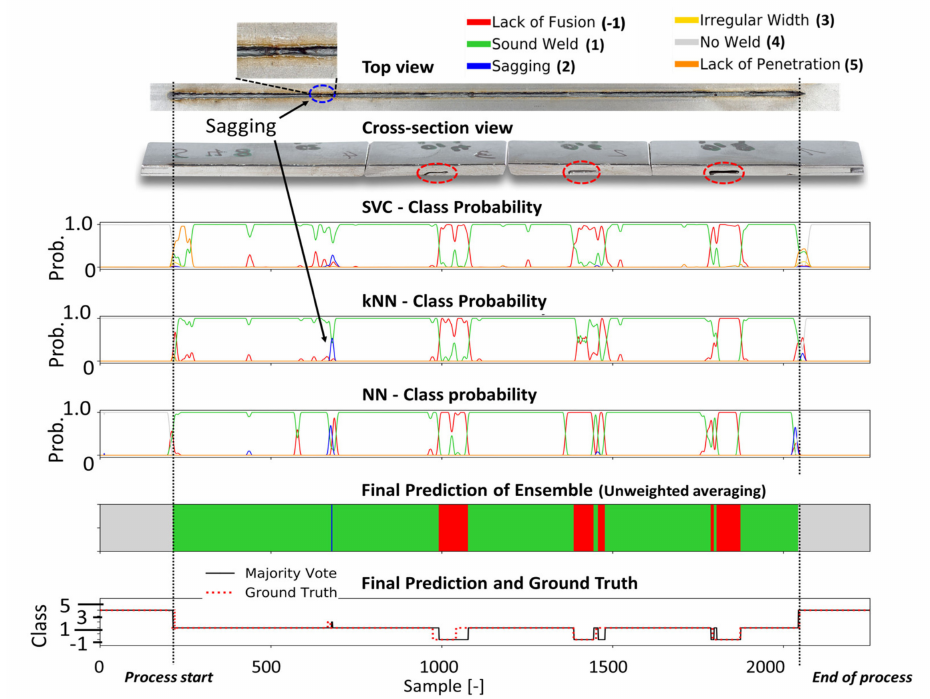
Figure 12. The metallographic characterization, the resulting ground truth data and the classification results for weld 48 based on the proposed ensemble CNN-GRU